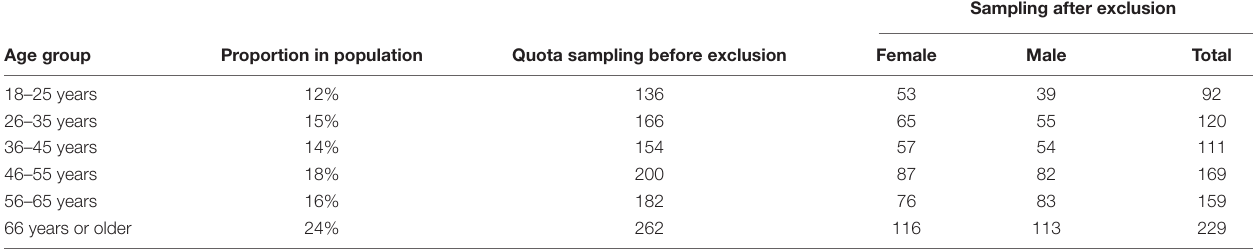
TABLE 4 | Proportions of German age groups (in 2018) and the derived sampling goals along with the final sample proportions in Study 2.